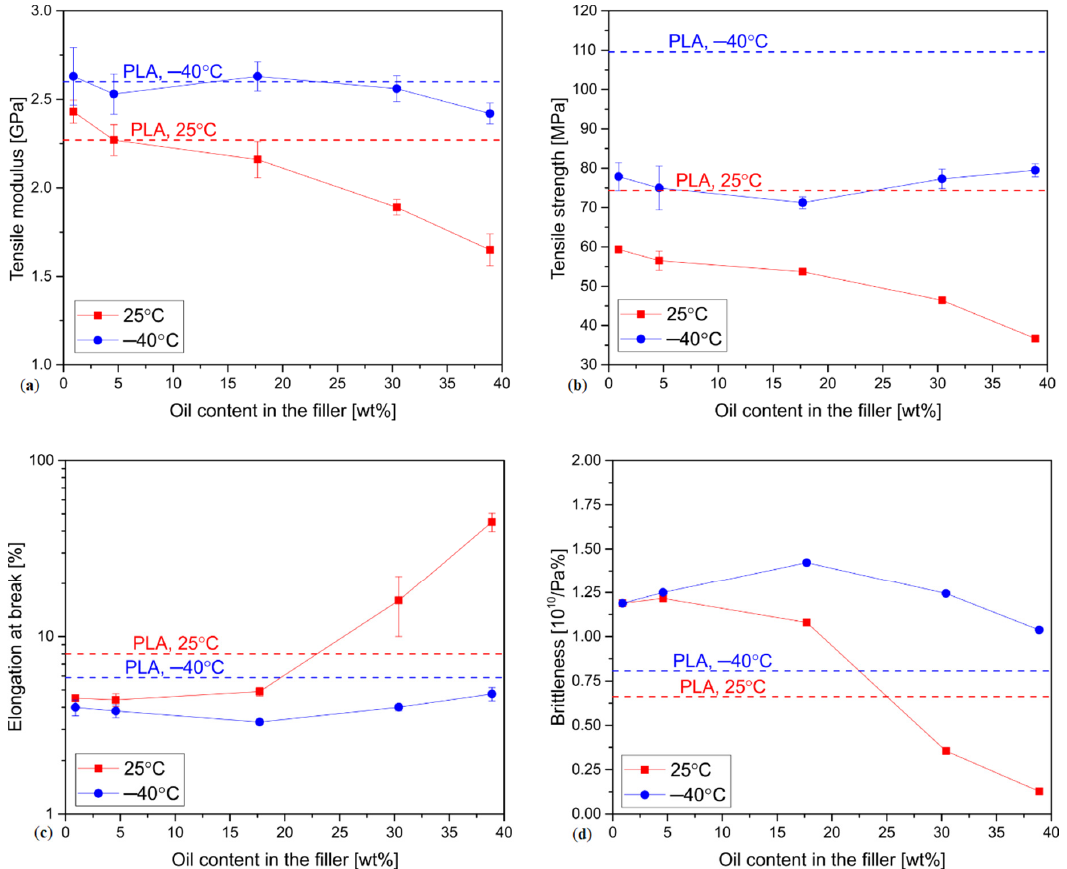
was statistically significant ( p -values < 0.05).